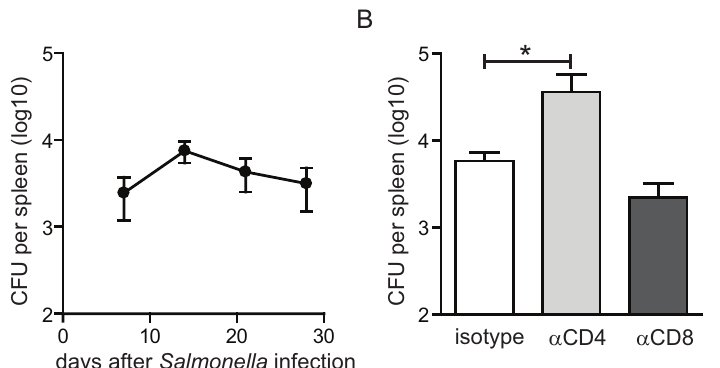
Figure 2. CD4 + T cells reduce the burden of virulent Salmonella infection. C57BL/6 mice were infected orally with 1 6 10 7 virulent Salmonella Typhimurium. (A) At day 7, 14, 21 and 28 post-infection, the Salmonella CFU in the spleen were determined. Data show the mean 6 SEM of 5–7 mice per timepoint. (B) At the onset of Salmonella infection, CD4 + or CD8 + T cell populations were depleted with anti-CD4 (clone GK1.5) or anti-CD8 (clone 2.43) monoclonal antibodies and at day 14 post-infection recoverable Salmonella CFU were determined. Graph shows mean + SEM for 5–6 mice per group. Statistical significance between groups is indicated (Mann-Whitney test, * p , 0.05). Experiments were performed twice with similar results.